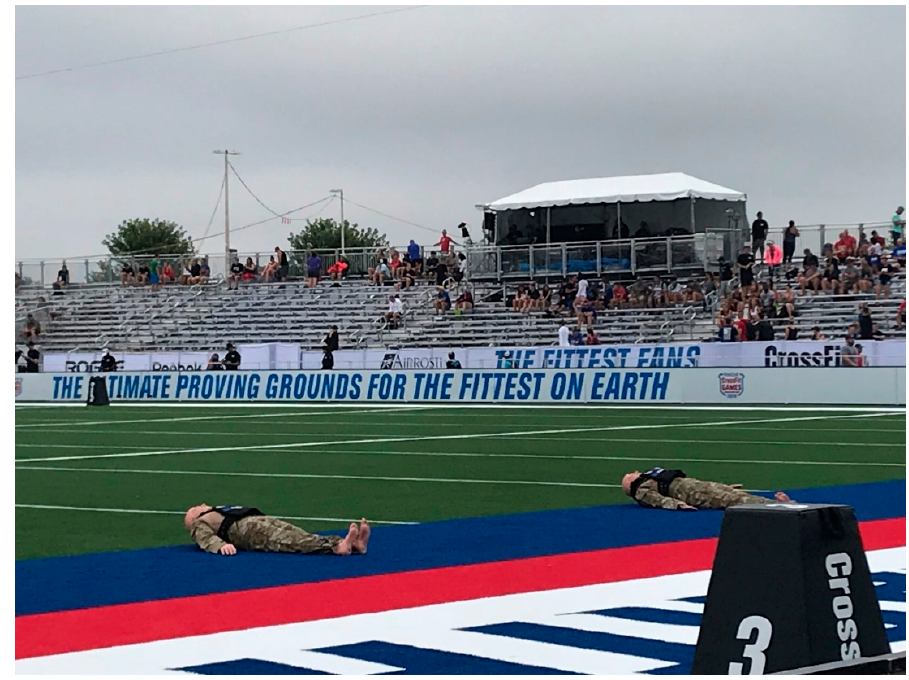
Figure 2. Rescue Randy, prostrate on the field, before the Battleground event begins. Photo by author.